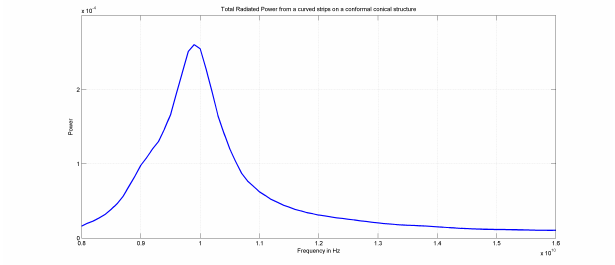
Fig. 13. Total scattered power for plane wave